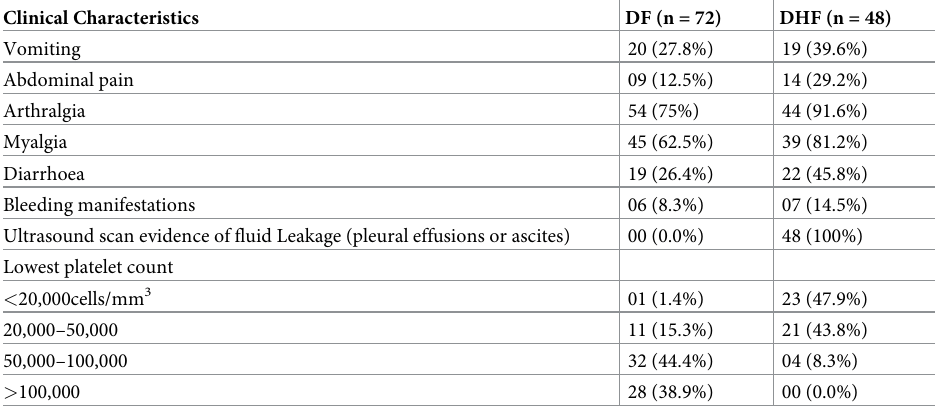
Table 1. Clinical and laboratory features of patients recruited for the study with � 4 days of